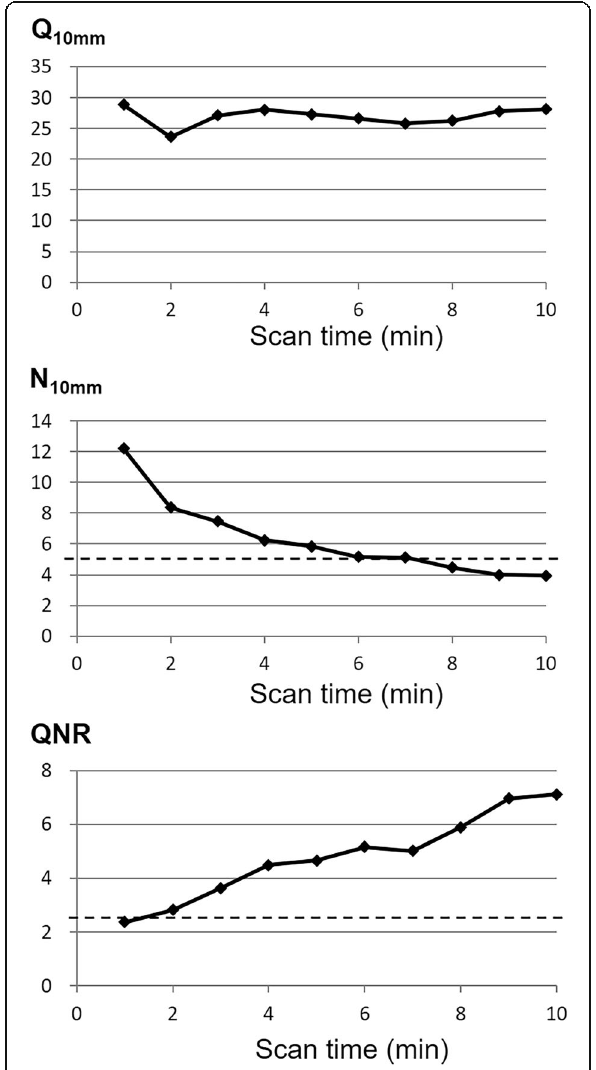
Fig. 8 The relationships of the % contrast ( Q H,10mm ), the % background variability ( N 10mm ), and the QNR with different scan times. The dotted lines indicate the recommended values ( N 10mm < 5.6%, QNR > 2.8)